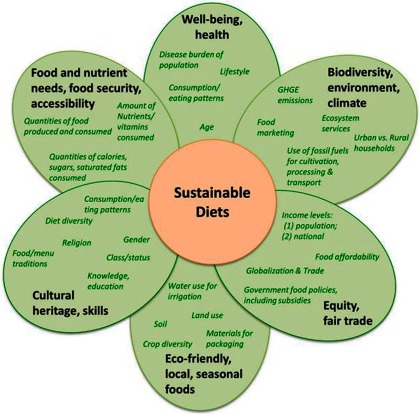
Components of the Sustainable DietAbbreviation: GHGE, greenhouse gas emissions.Source: Adapted from Johnston, Fanzo, and Cogill (2014).24